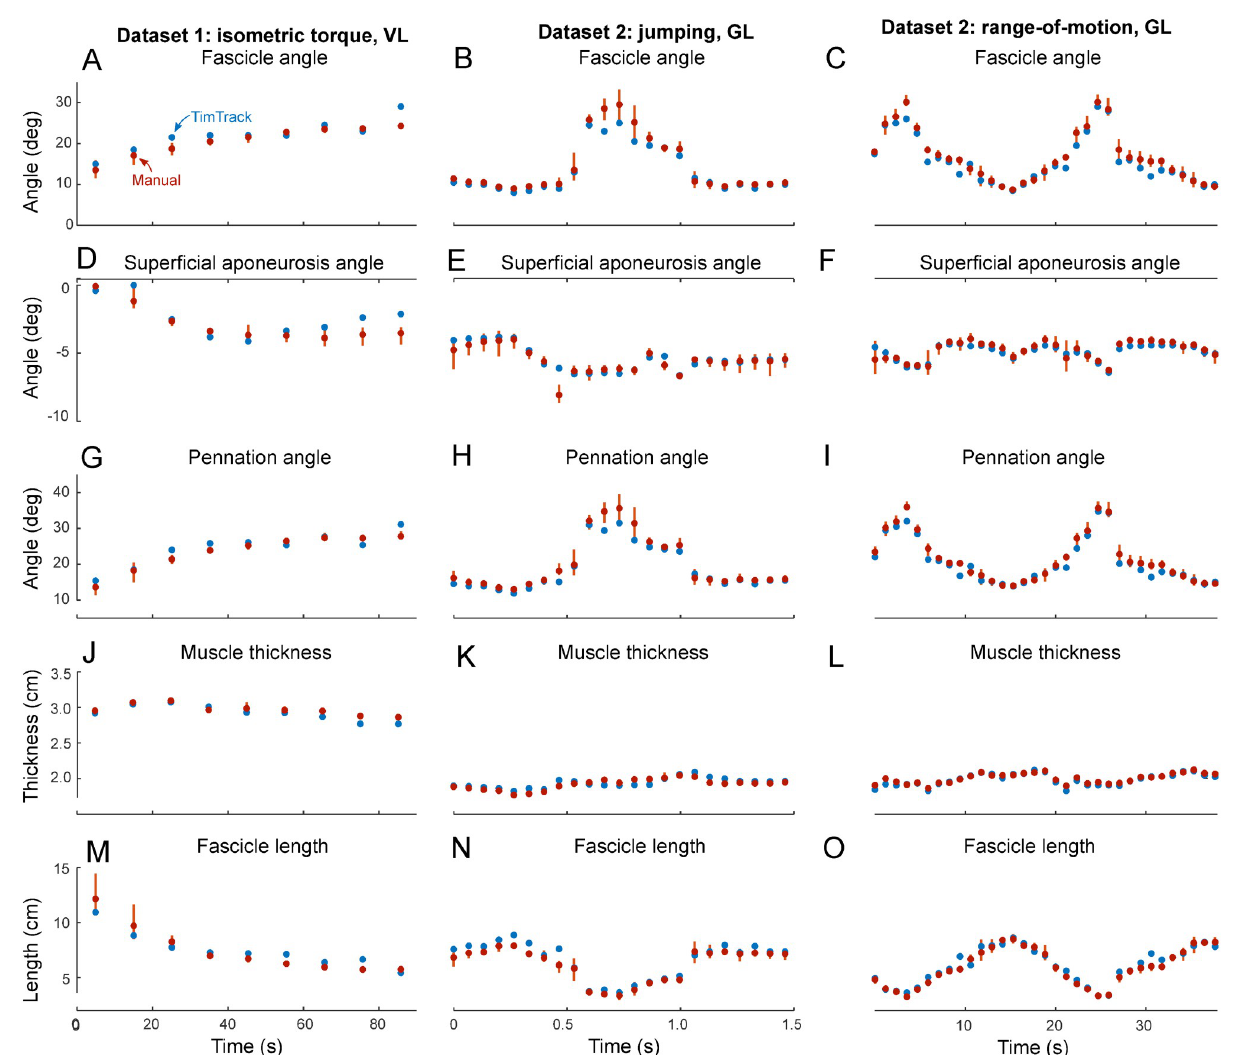
Fig 4. Estimates of TimTrack algorithm and manual observer on geometric muscle features in two datasets (1–2). Estimates of TimTrack algorithm (blue dots) and manual observers (red dots) for fascicle angle (A-C), superficial aponeurosis angle (D-F), pennation angle (G-I), muscle thickness (J-L) and fascicle length (M-O) of vastus lateralis (VL) during isometric torque production (left column), gastrocnemius lateralis (GL) during jumping (middle column) and gastrocnemius lateralis (GL) during range-of-motion movement (right column). Vertical red lines indicate the range of manual estimates for each image. When manual estimates are similar, this connecting line may not be visible. Similarly, when manual and TimTrack’s estimates are nearly identical, the latter may not be visible. Ultrasound images for manual estimation were selected such that they were spaced equidistantly and included the entire range of fascicle angles and -lengths present in each